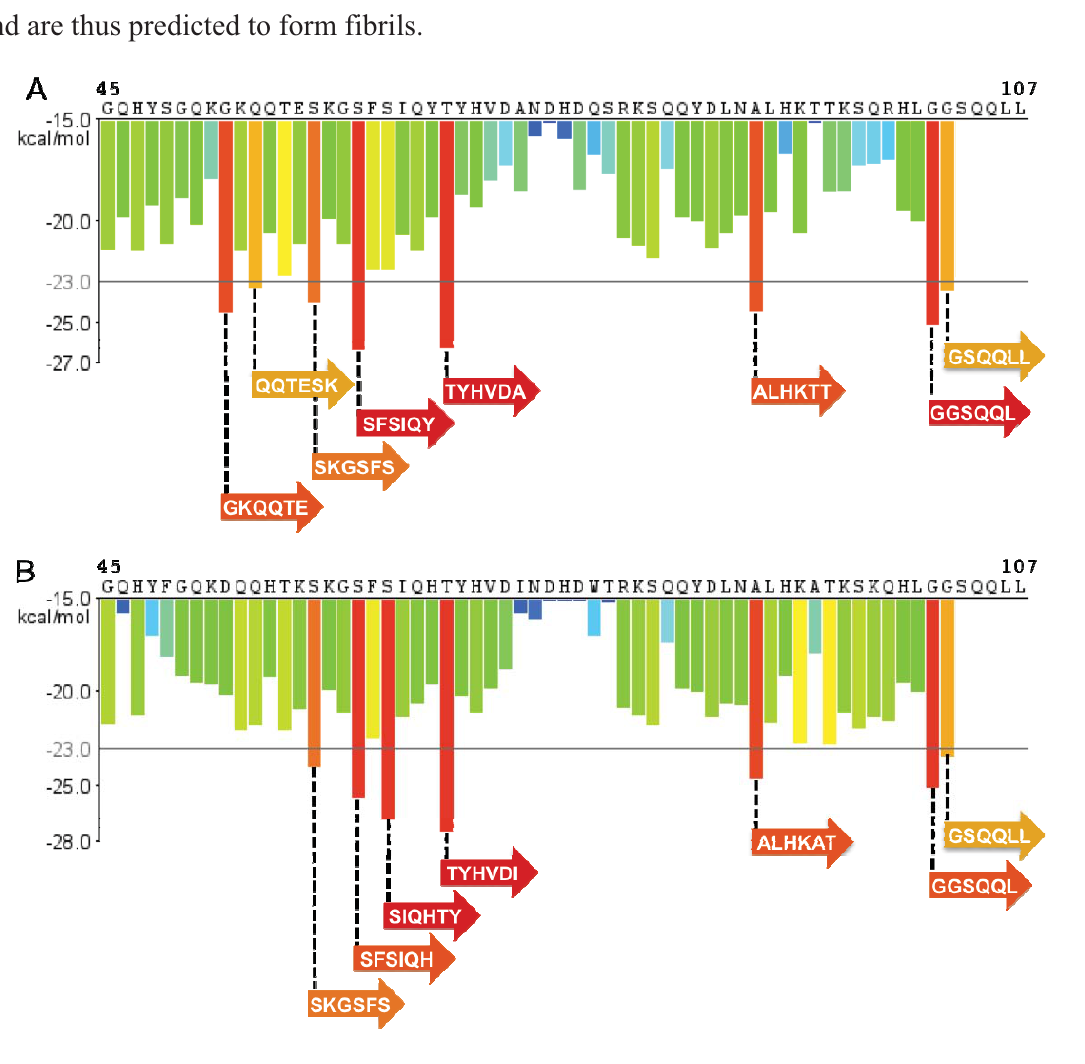
Figure 7. SEM1 and SEM2 have several regions of high fibrillization propensity. ( A ) The Zipper DB histogram of SEM1(45-107) indicates eight hexapeptide segments with